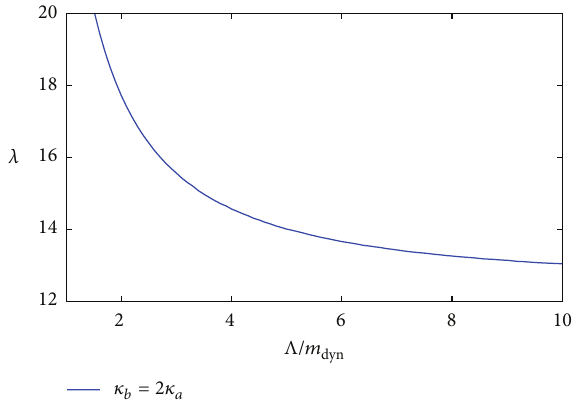
Figure 7: Cutoff dependence of Yukawa coupling, where the cutoff Λ is in units of the dynamical quark mass 𝑚